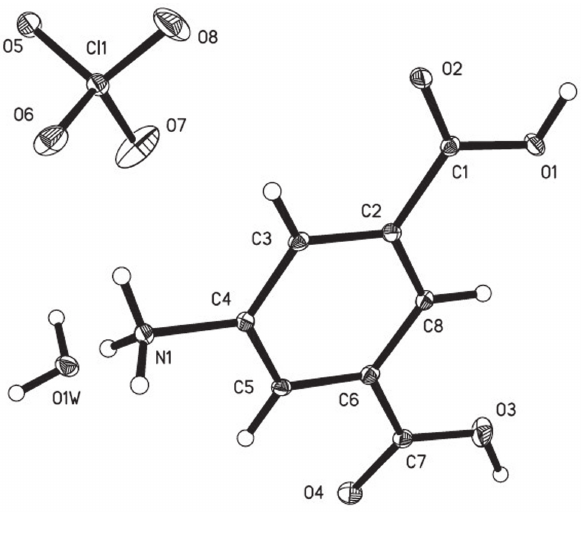
Table 1: Data collection and handling.